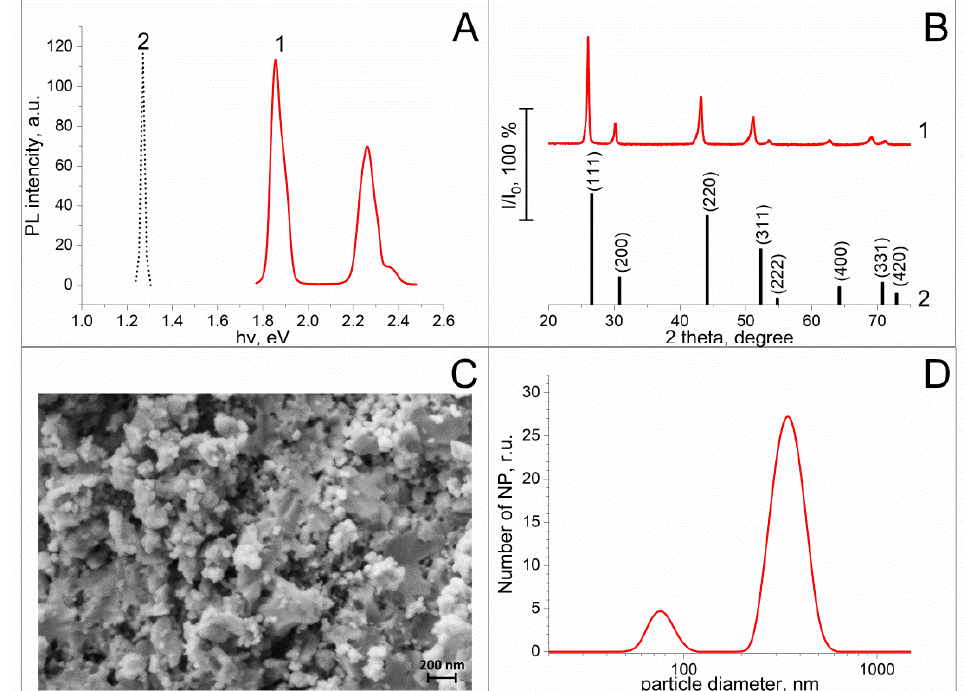
Figure 1. Characteristics of nanosized fluorophores (Sr 0.46 Ba 0.50 Yb 0.02 Er 0.02 F 2.04 ). ( A ) Photolumines- cence (PL) (curve 1) of the nanoparticles in acetone in the PAR range, which was excited with IR light diode (curve 2). ( B ) X-ray diffraction pattern for the nanoparticles after heat treatment at 600 °C (1) and JCPDS #06-0262 for SrF 2 (2). ( C ) SEM images for samples after a heat treatment at 600 °C. ( D ) Size distribution of nanoparticles (NP) of fluorophores obtained using dynamic light